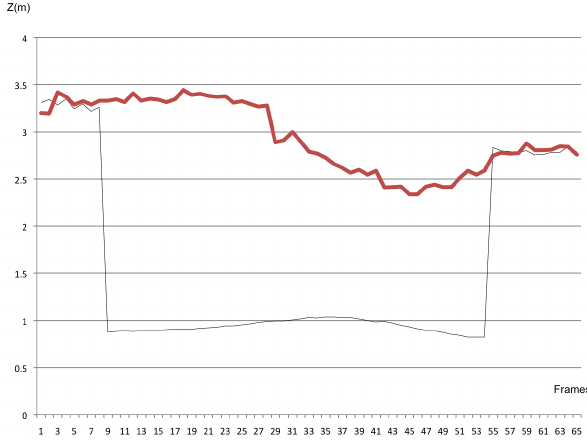
Figure 33. Outlier zone: this graph is a detail of the graph of the Figure 32, from the frame 44 to frame 108, here we can compare the estimation in the outlier zone with and without the use of the filter. The black curve is the estimation without filter and the red curve is the estimation with filter. The frame 44 was renumbered with the number